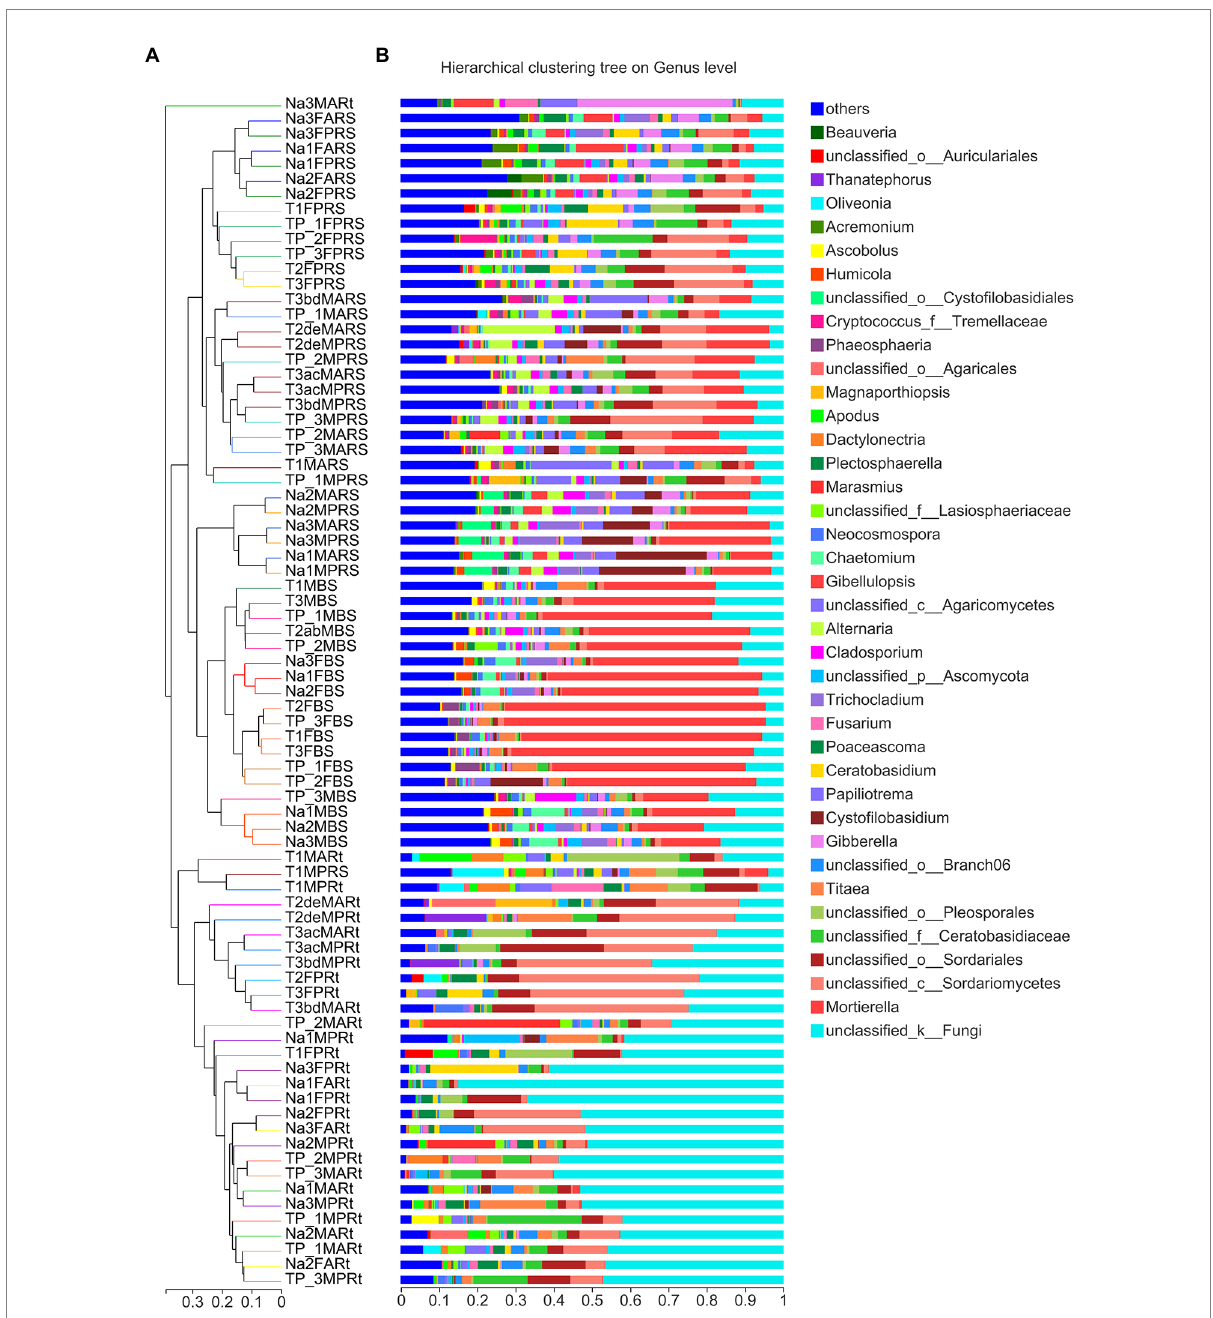
FIGURE 3 Hierarchical clustering of all samples according to Bray–Curtis distance and fungal microbiota composition of each sample at the genus level. (A) Hierarchical clustering tree of all 79 samples belonging to 25 groups; the branch length represents the distance between samples. (B) The fungal composition of 79 samples at the genus level displayed via stacked column charts. Each sample’s dominant genera are displayed in the stacked column, and those genera with relative abundances less than 5% were combined as others. The treatment details are shown in Figure 1, in addition to sample names starting with uppercase letter T and digits referring to the sorghum line